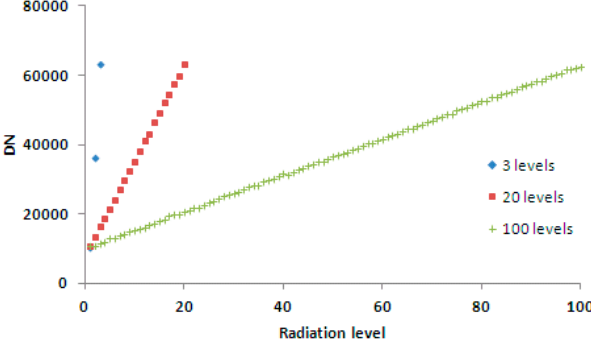
Figure 10. The vertical profile of the calibration data for column 50 corresponding to Figure 9. The horizontal axis is radiation level, and the vertical axis is DN.